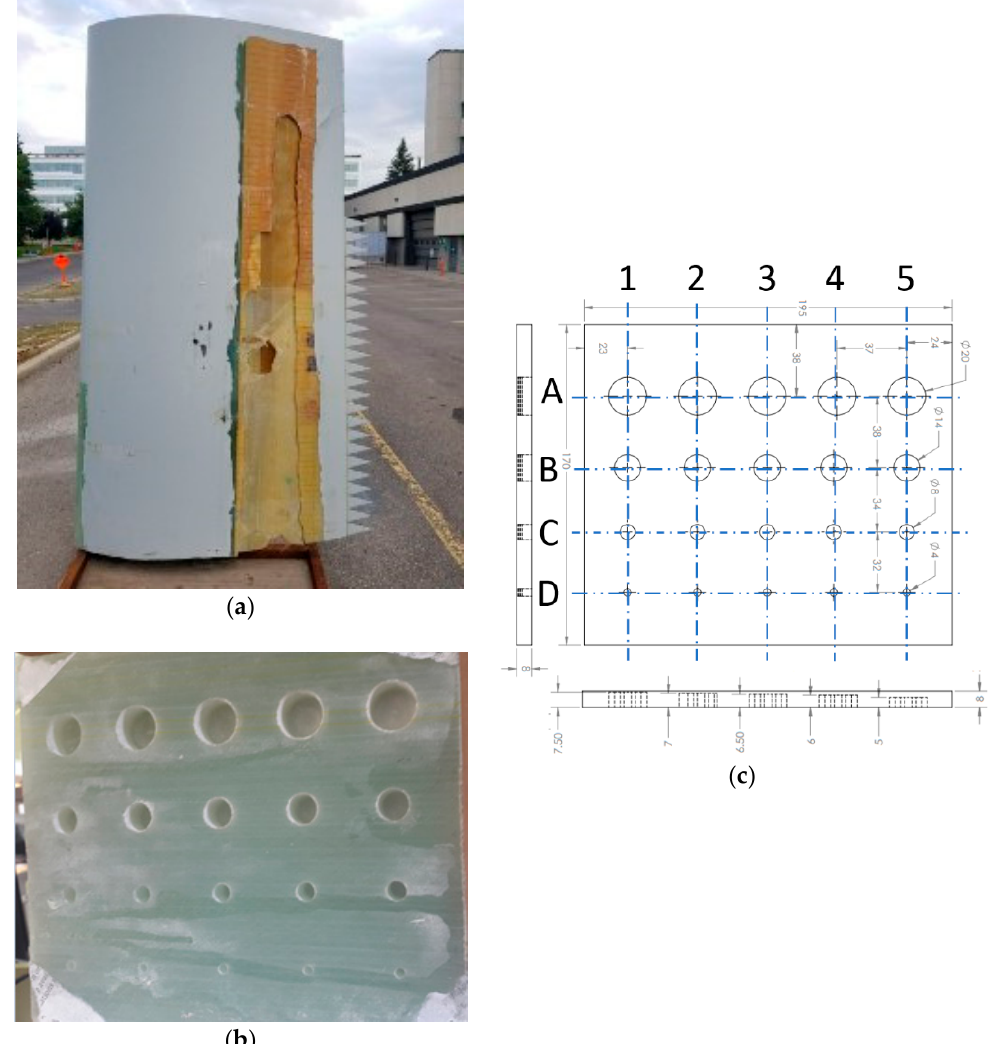
Figure 1. ( a ) The damaged wind turbine blade. ( b , c ) The defect plate with flat-bottomed holes. All holes were drilled from the rear and did not penetrate the outer surface.